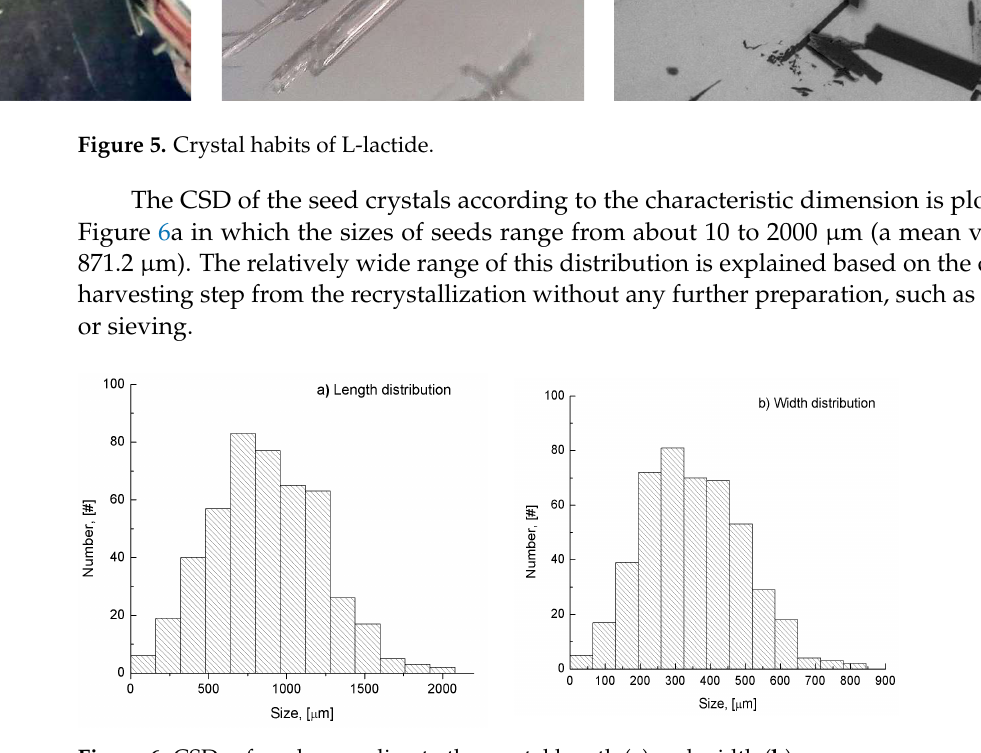
Figure 6. CSDs of seeds according to the crystal length ( a ) and width ( b